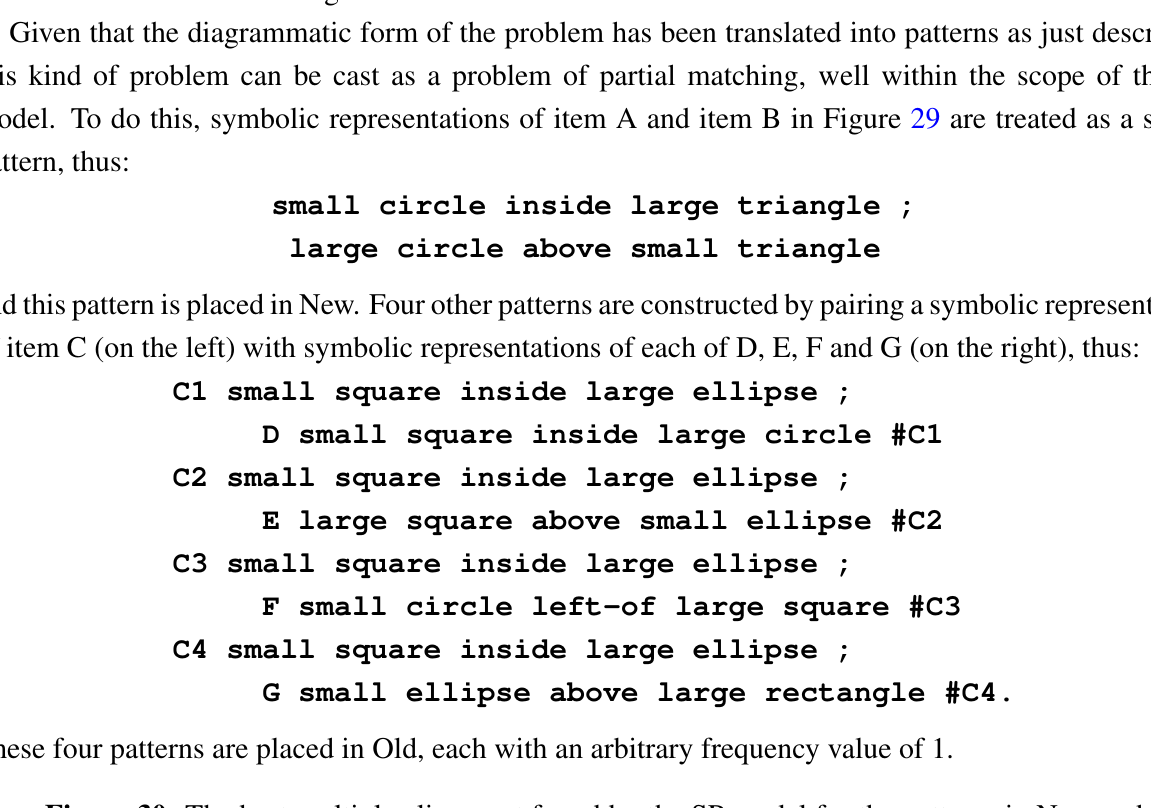
Figure 30. The best multiple alignment found by the SP model for the patterns in New and Old as described in the